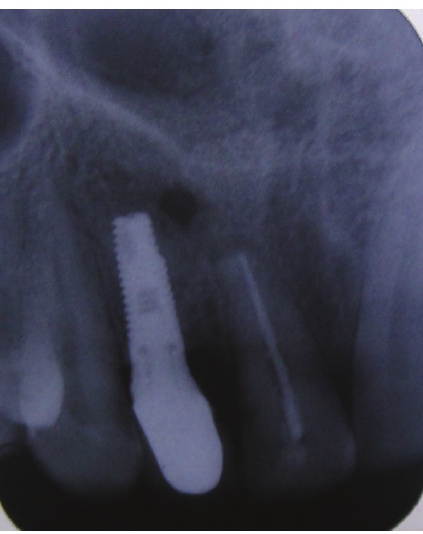
Figure 13: IOPA radiograph of the restored site 1 year after